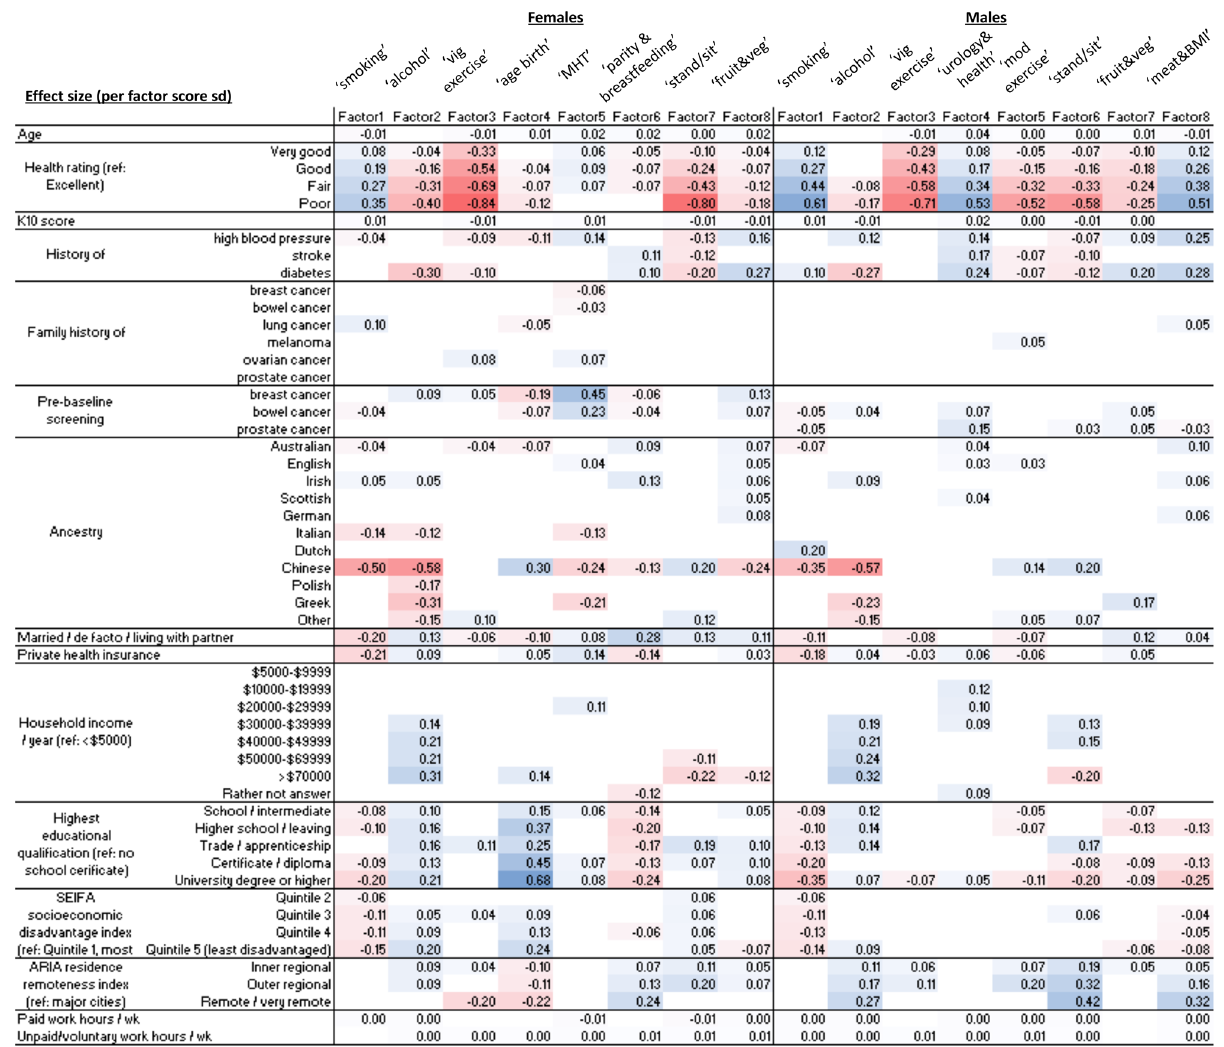
Figure 3. Associations between combined factors and sociodemographic characteristics for females and males. Figure shows coefficients from linear regression of each factor (in columns) jointly on all sociodemographic characteristics (in rows), where estimate has P < 0.001. Estimates shown are per unit of standard error for each factor. Blue: positive association, red: negative association. sd standard deviation; vig vigorous, age birth age at childbirth, MHT menopausal hormone therapy, stand/sit standing/sitting, veg vegetables, mod moderate, BMI Body Mass Index, / wk per week; pre-baseline screening row for prostate cancer here refers to PSA